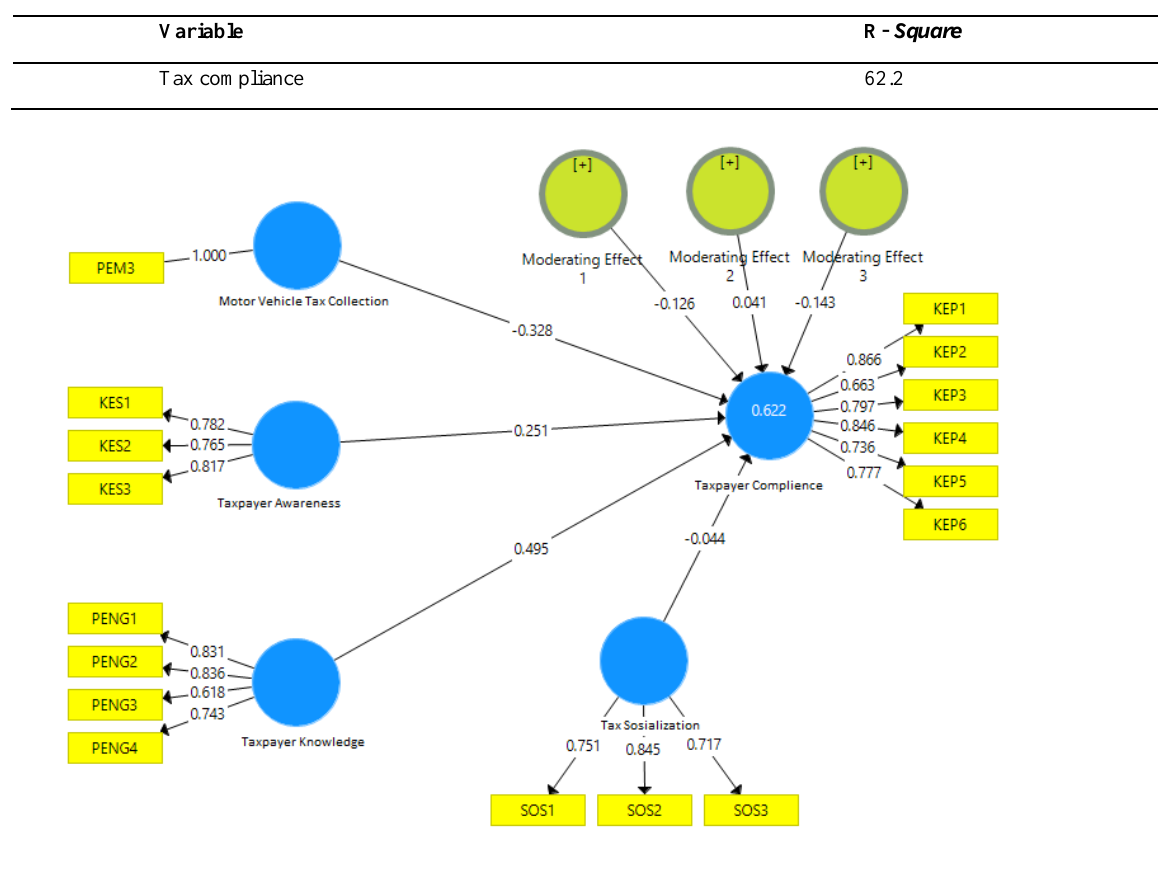
Table 7: Variables, R- square